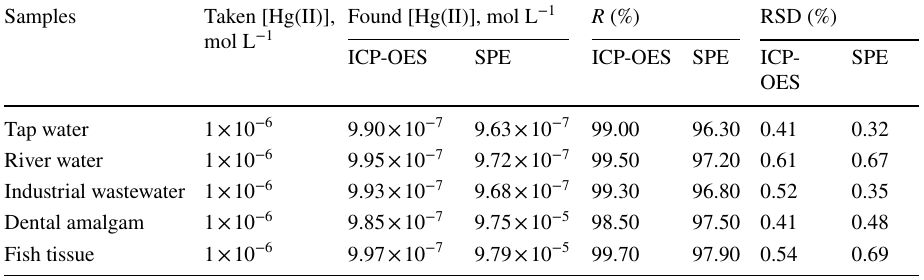
Table 3 Potentiometric determination of Hg(II) in different real samples using modified SPE